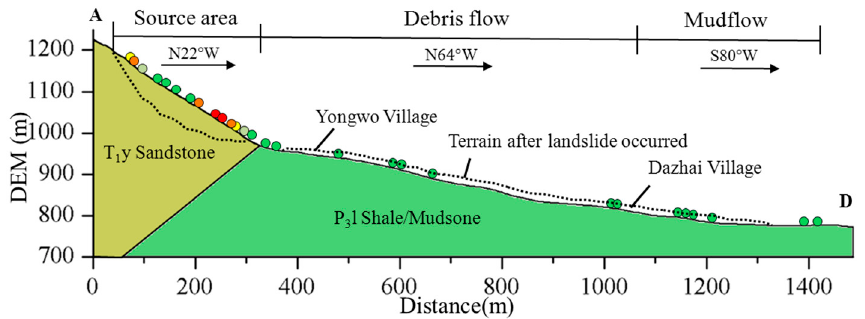
Figure 5. Profile of the average deformation rate, stratigraphic structure, and elevation along the polyline ABCD shown in Figure 3. The legend of the deformation rate is the same as used in Figure 3.